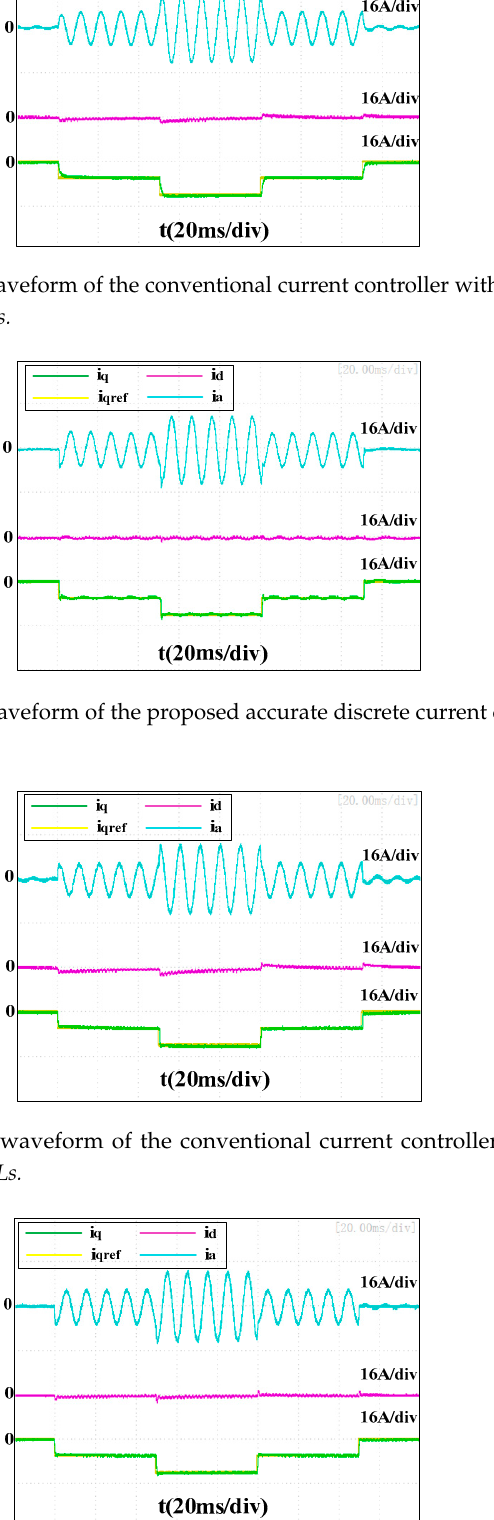
Figure 12. d-q axis current waveform of the conventional current controller with feedback decoupling at 6000 rpm with Kp = 500 π Ls.